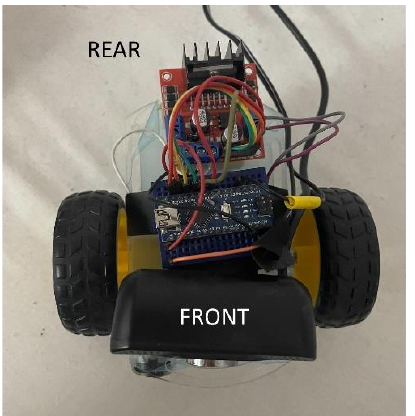
Figure 1. Hardware connection between the engine, motor driver and Arduino Board [31].